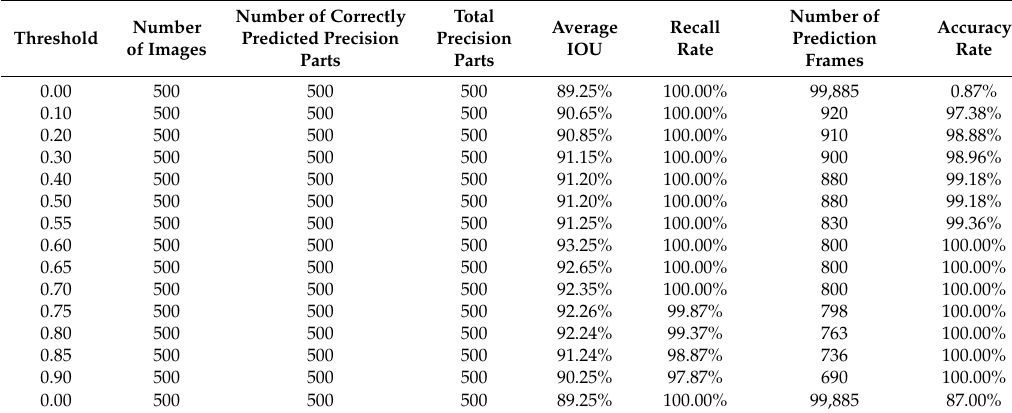
Table 4. Results of the verification